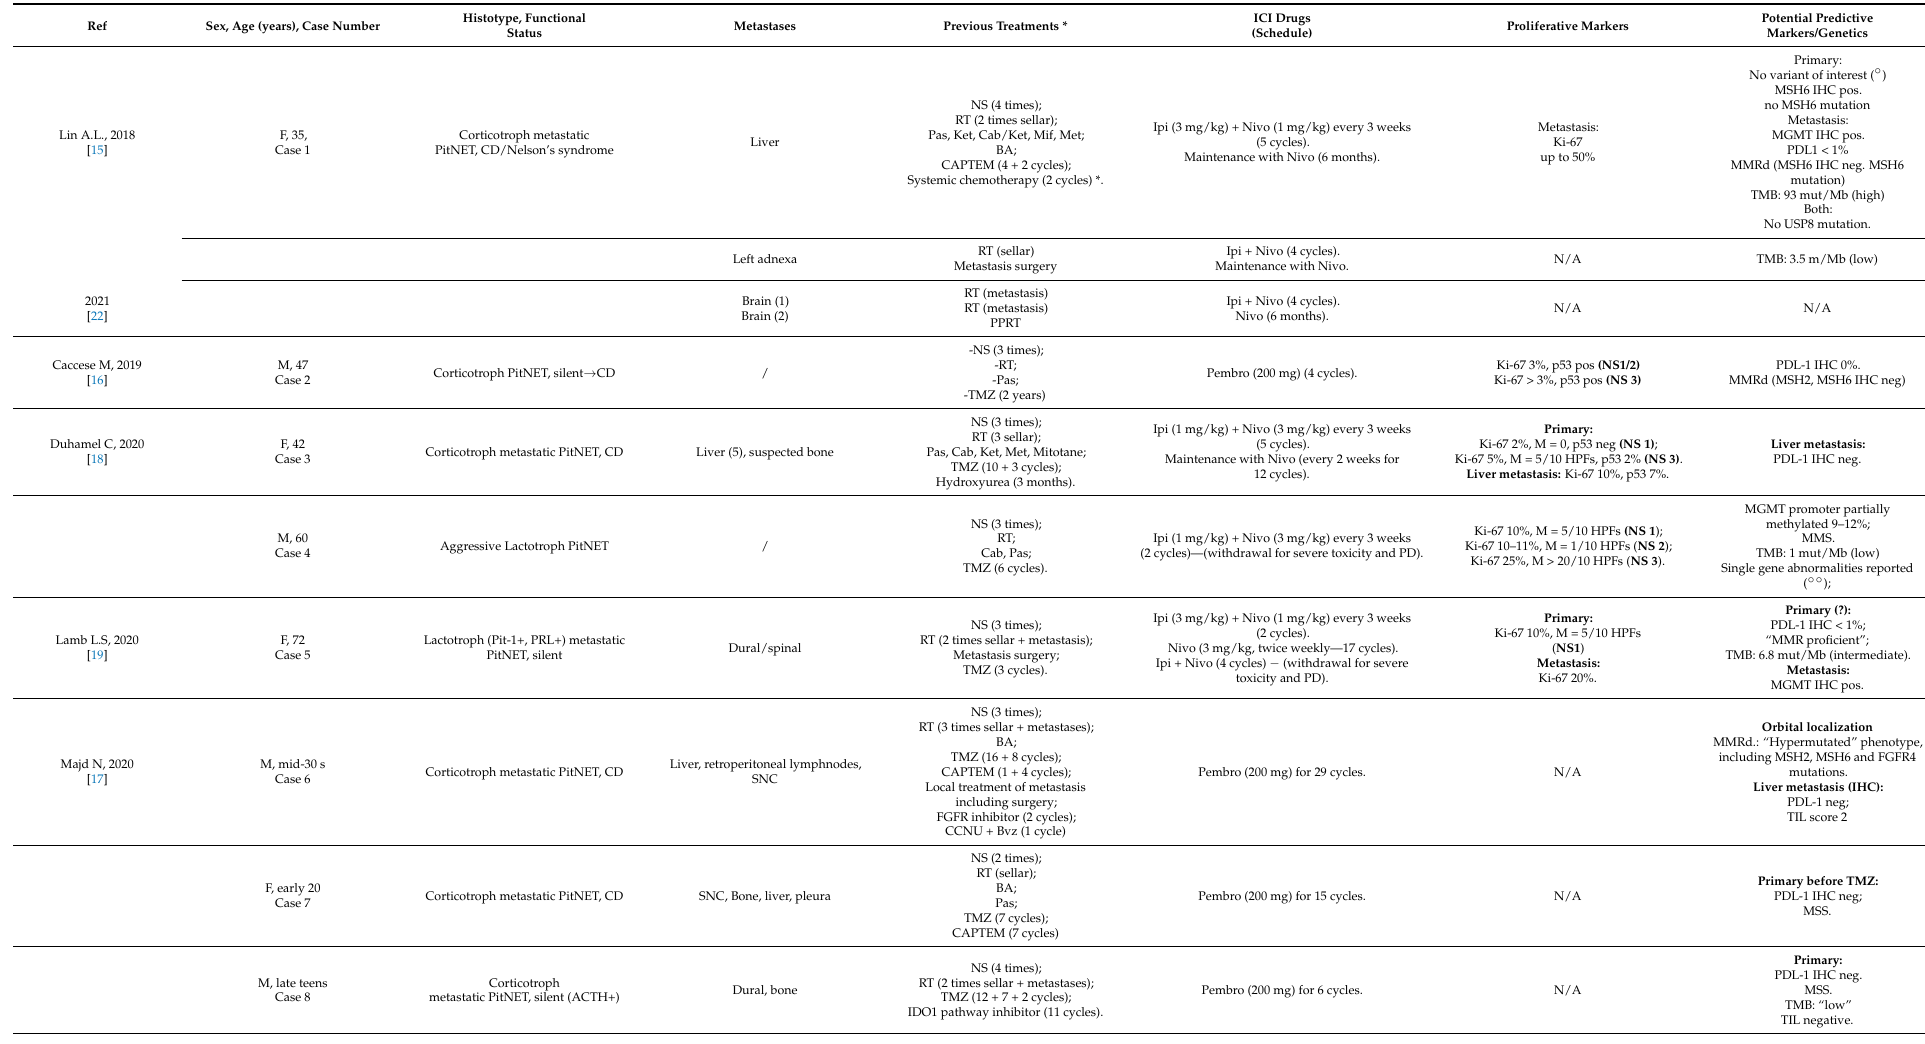
Table 1. Characteristics of aggressive and metastatic PitNETs treated by immune checkpoints inhibitors